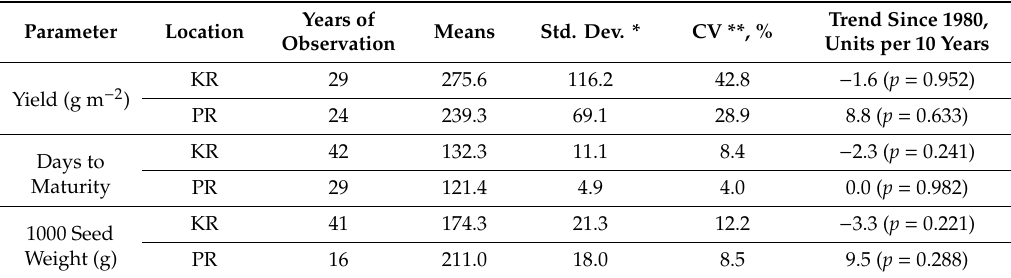
Table 2. Year-to-year variation in the characteristics of the soybean standard varieties in KR and PR.